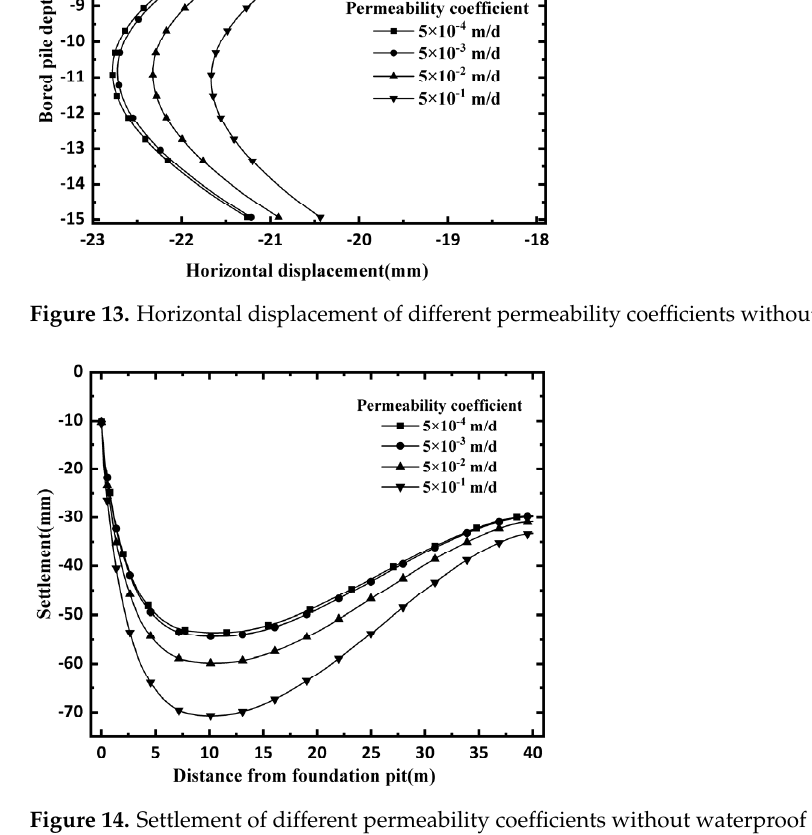
Figure 15. Flow network diagram with permeability coefficient of 5 × 10 -1 m·d -1 . Figure 16. Flow network diagram with permeability coefficient of 5×10 -2 m·d -1 . 6. Conclusions (1) The horizontal displacement of bored piles and the surface settlement are im- portant indicators to measure the stability of foundation pit engineering. However, con- sidering the seepage effect of dewatering excavation in numerical simulation is closer to the actual situation of the project, which can effectively improve the accuracy of the nu- merical simulation. The study found that the calculated value of the fluid-solid coupling model is generally larger than that of the single case only considering soil plasticity, and is closer to the actual monitoring value. By analyzing the calculated values of the shear